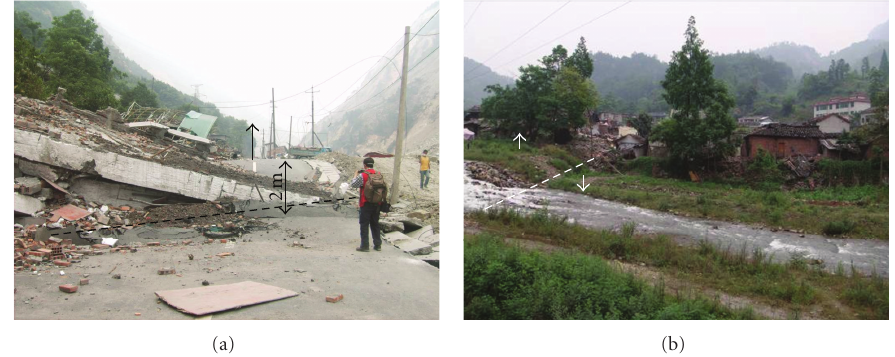
Figure 3: Thrust surface rupture and damage. The more severe damage is on the hanging wall.